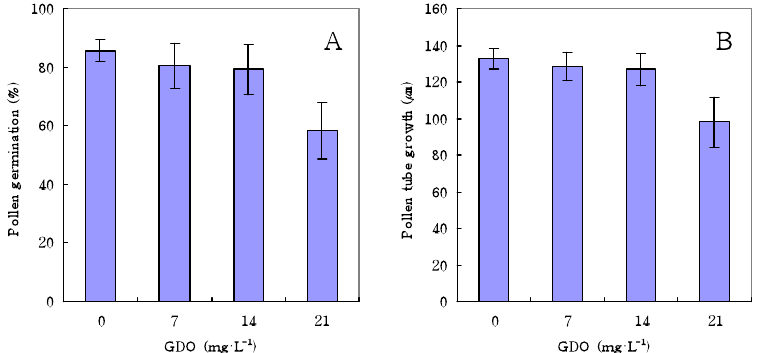
Fig. 2: Effects of PGDO concentrations in the pollen liquid diluent on pollen germination rate (A) and pollen tube growth (B) of ‘Matua’ kiwi in vitro. Vertical bars represent ± SD. Results are from five replicates. Replicates above consist of approximately 50 pollen grains each.